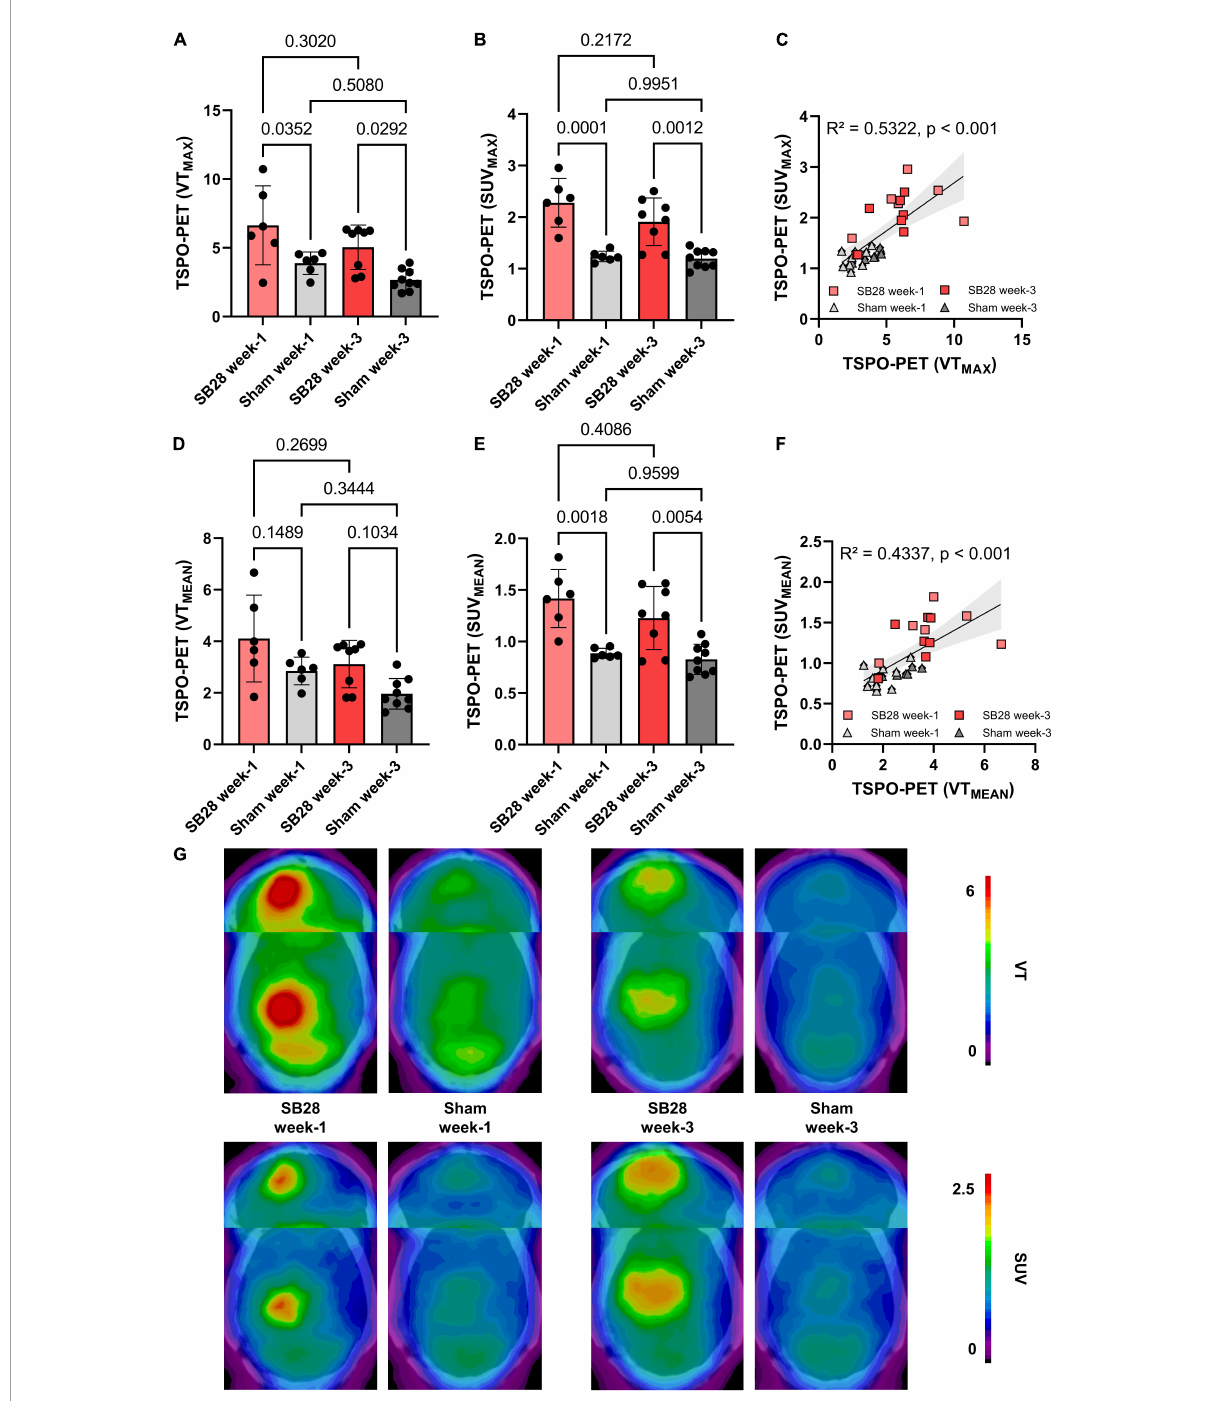
FIGURE3 Quantitative assessment of TSPO in SB28 and sham mice. (A–C) Maximum volumes of distribution (VT) and standardized uptake values (SUV) of the lesion site in SB28 and sham mice at week-1 and week-3 as well as their correlation. Maximum values were obtained using the hottest voxel in individual 50% threshold tumor VOIs or a standardized sham VOI. (D–F) Mean volumes of distribution (VT) and standardized uptake values (SUV) of the lesion site in SB28 and sham mice at week-1 and week-3 as well as their correlation. Mean values were obtained using the average signal intensity of the individual 50% threshold tumor VOIs or a standardized sham VOI. P -values are indicated for comparisons of SB28 and sham mice per time-point and for the comparison of week-1 and week-3 within groups. (G) Axial planes show group average images of SB28 and sham mice at both time-points upon a CT template. To avoid bias in visualization, n = 4 week-1 and n = 6 week-3 SB28 mice were used for average images due to exclusion of two mice per time-point with a deviating center of tumor